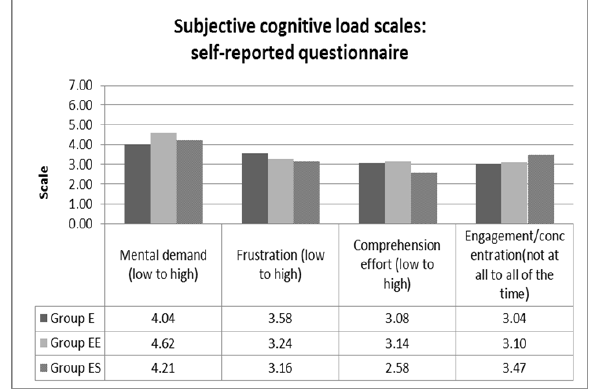
Figure 5. Average values for subjective self-reported questionnaire